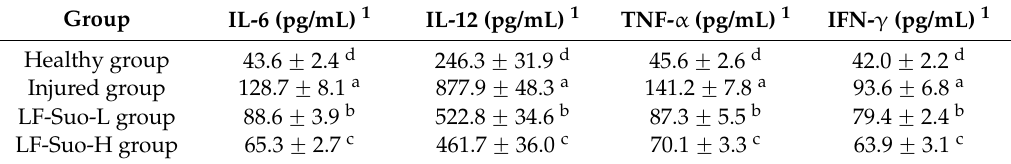
Table 5. Cytokine IL-6, IL-12, TNF- α and IFN- γ levels of studied mice.